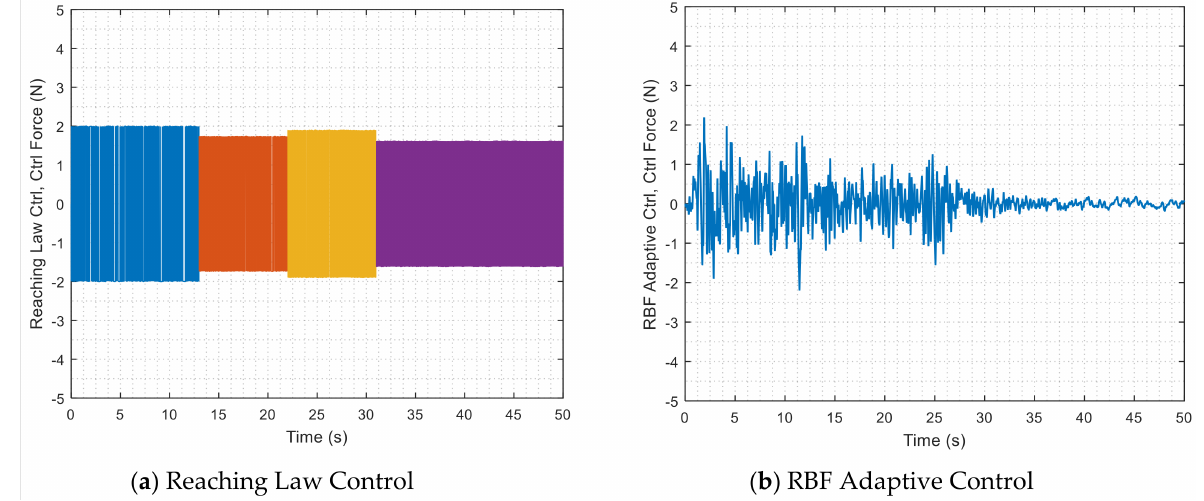
Figure 20. Structural Control Force.